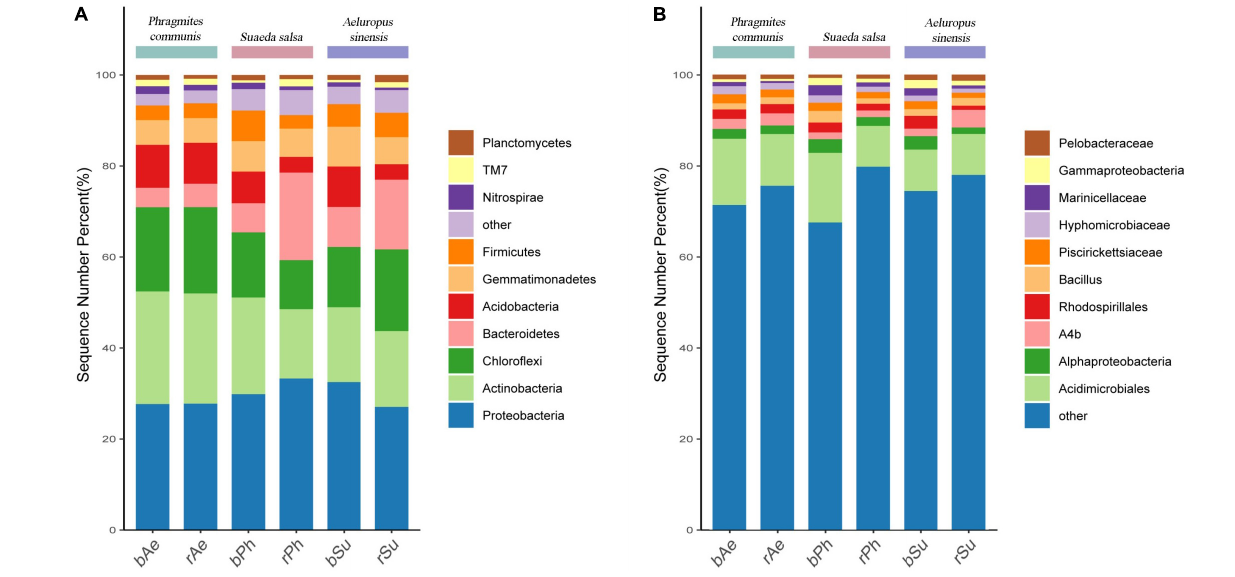
FIGURE 3 | Table of relative abundance of the top 10 bacterial phyla (A) and genera (B) in the rhizosphere and bulk soils of different halophytes.